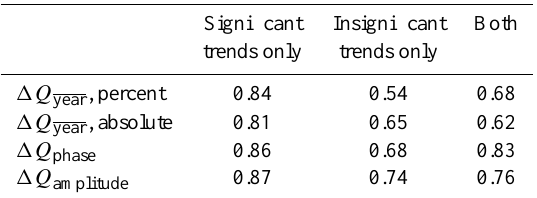
Table 2. Pearson’s r between annual streamflow trends and mean watershed